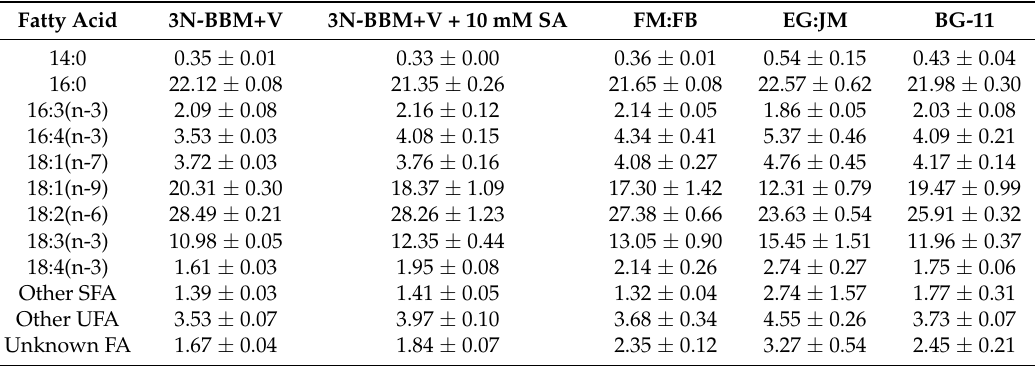
Table 2. Mean fatty acid composition % total ± S.D. (% TFA) of H. pluvialis cultivated in various autotrophic and mixotrophic